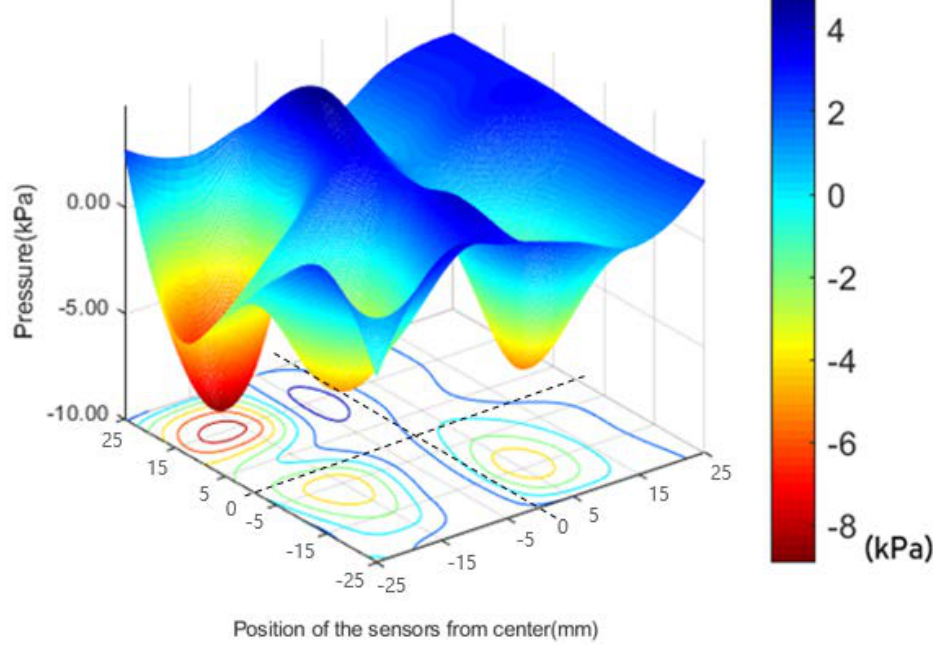
Figure 29. 3D Plot for Discrepancy in Peak Pressure (the 10th Case Pressure -Wet Average, ROLL).